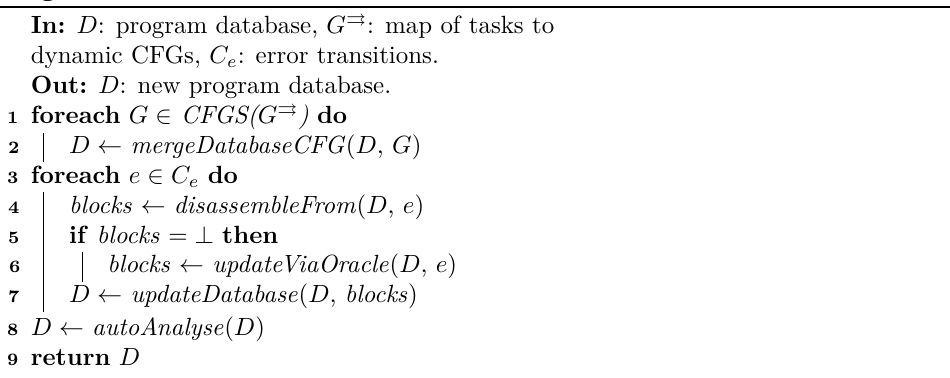
Algorithm 6: Feedback-driven